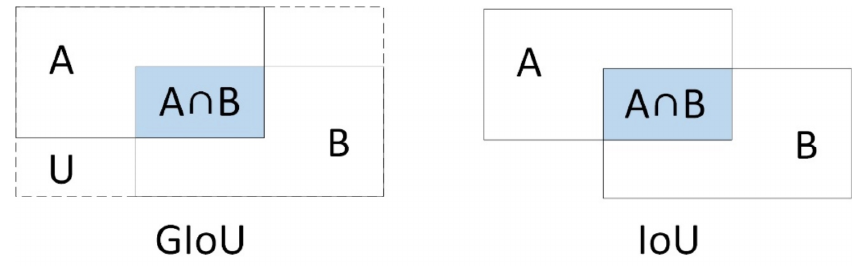
Figure 5. Comparison of GIOU and IOU.